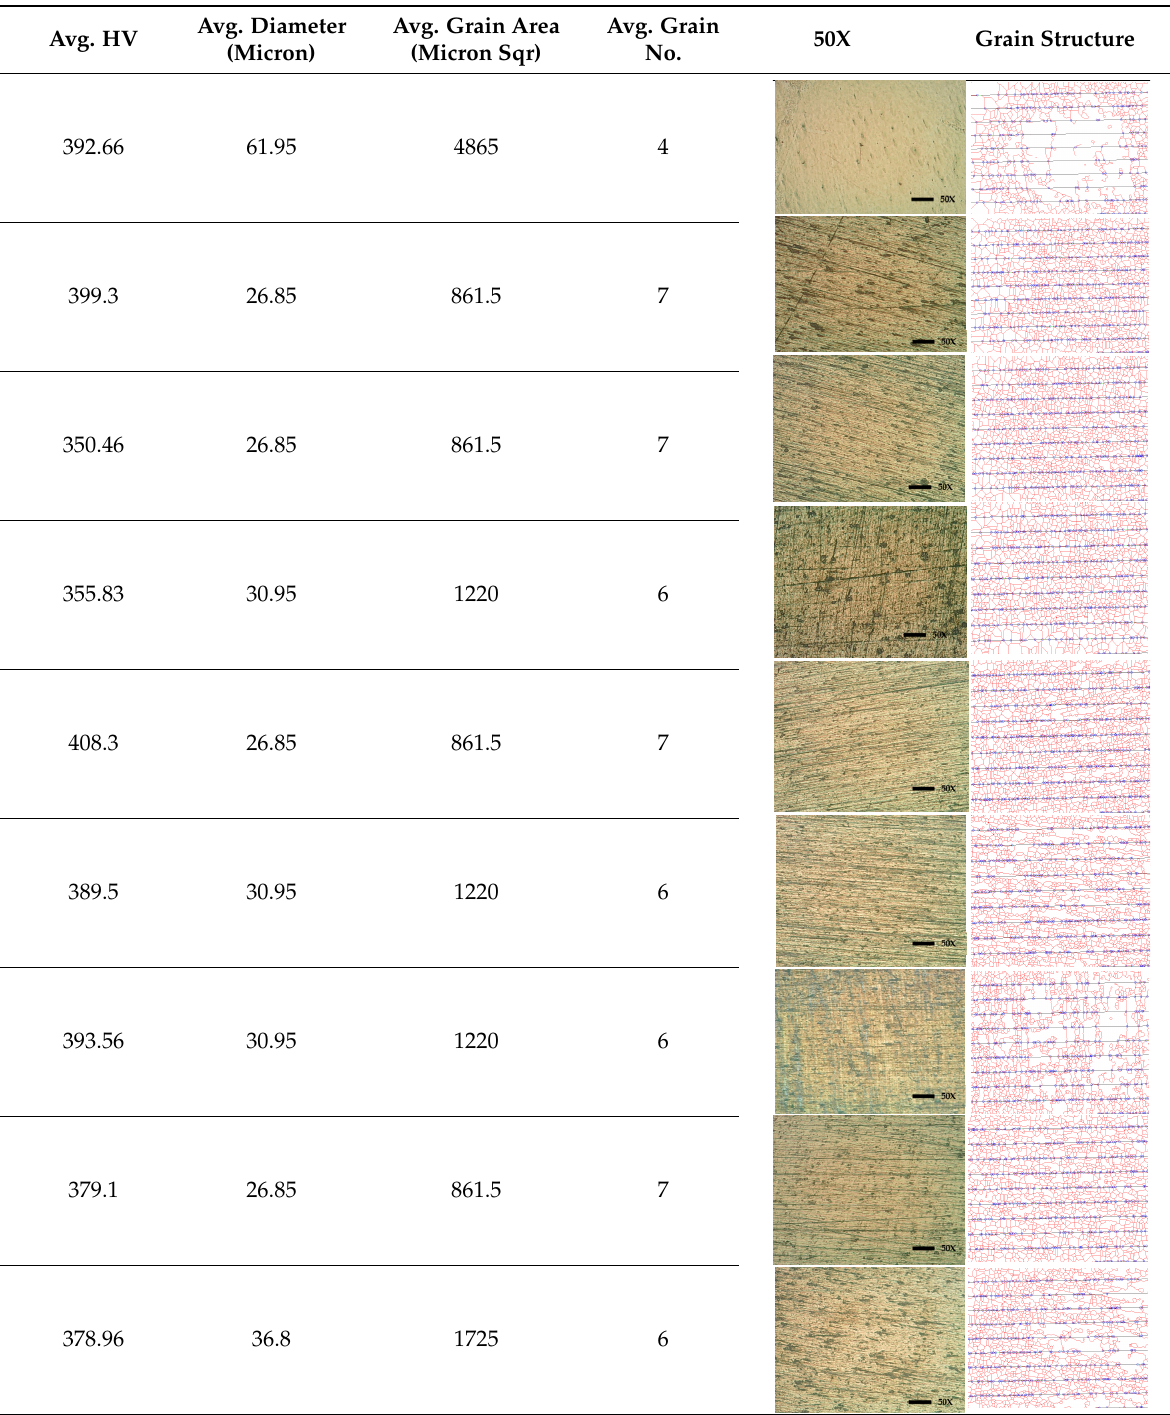
Table 4. Before Heating Hardness and Grain size.